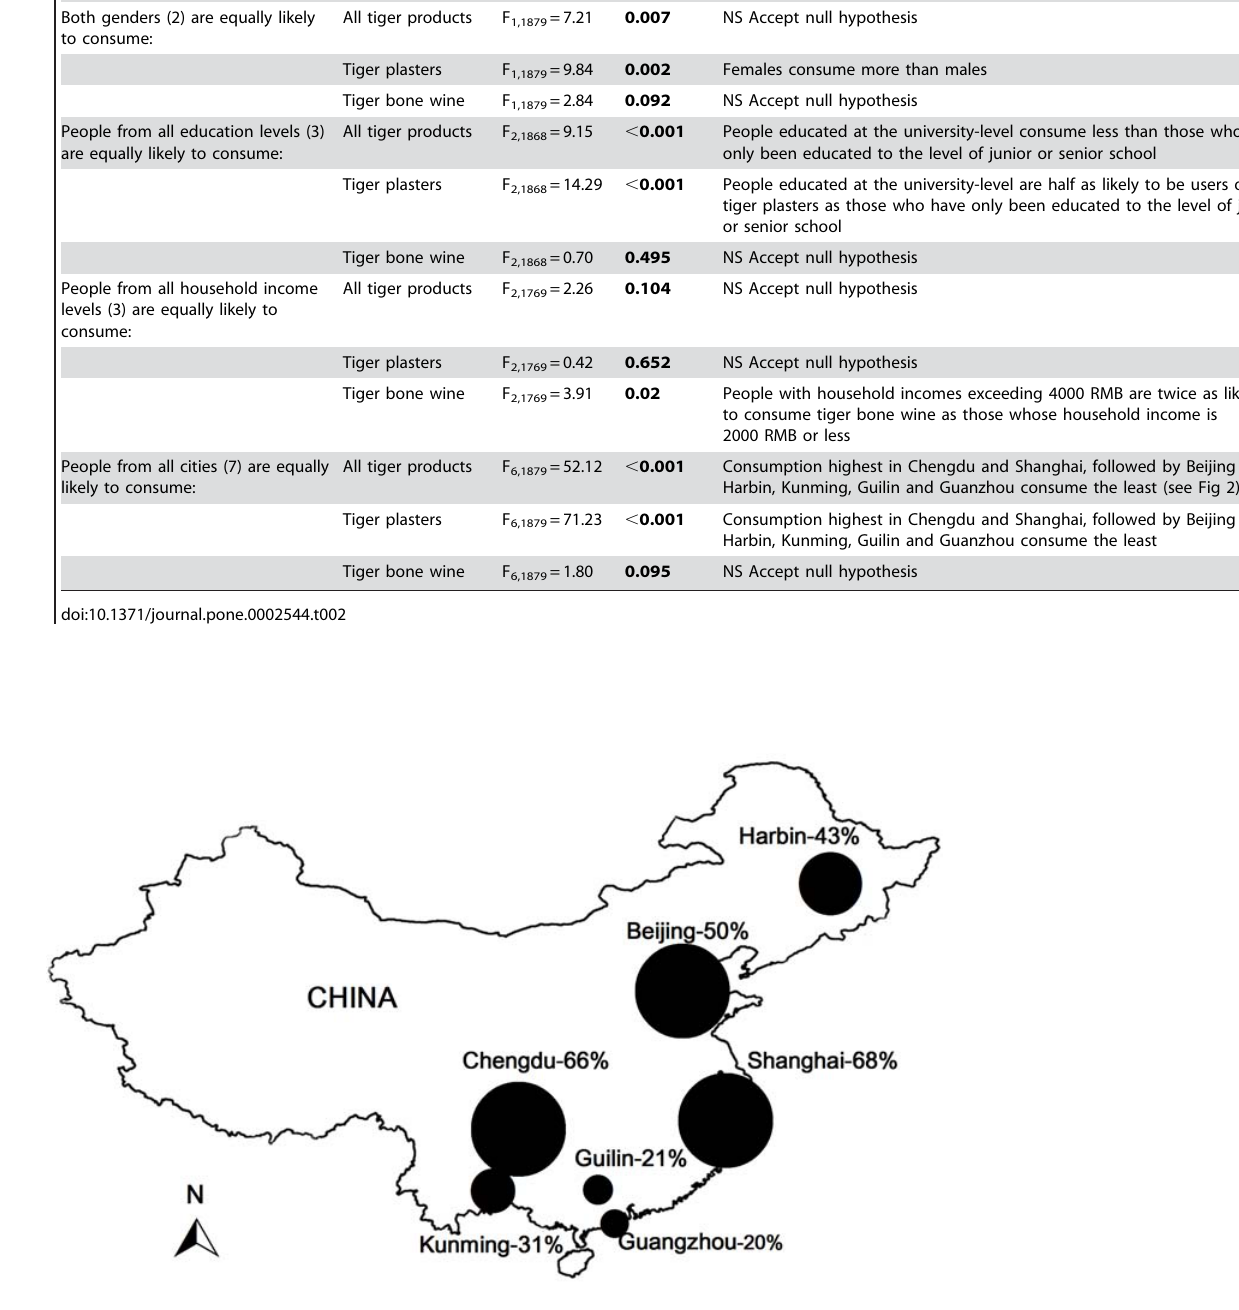
Figure 2. The prevalence of tiger consumption by residents of 7 Chinese cities. Prevalence of consumption was significantly different between cities (One way ANOVA, 6df, p , 0.001). A post-hoc Tukey HSD test split the cities into the following homogeneous subsets a) Shanghai and Chengdu, b) Harbin and Beijing, c) Kunming, Guilin and Guangzhou.